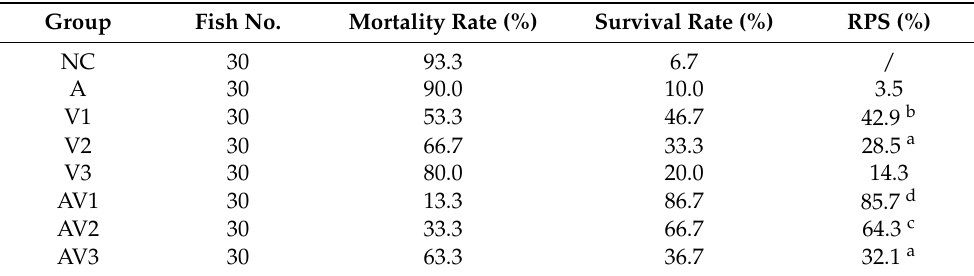
Table 3. Mortality rate and relative percentage survival (RPS) of fish challenged with the TiLV 2017A virus. Group Fish